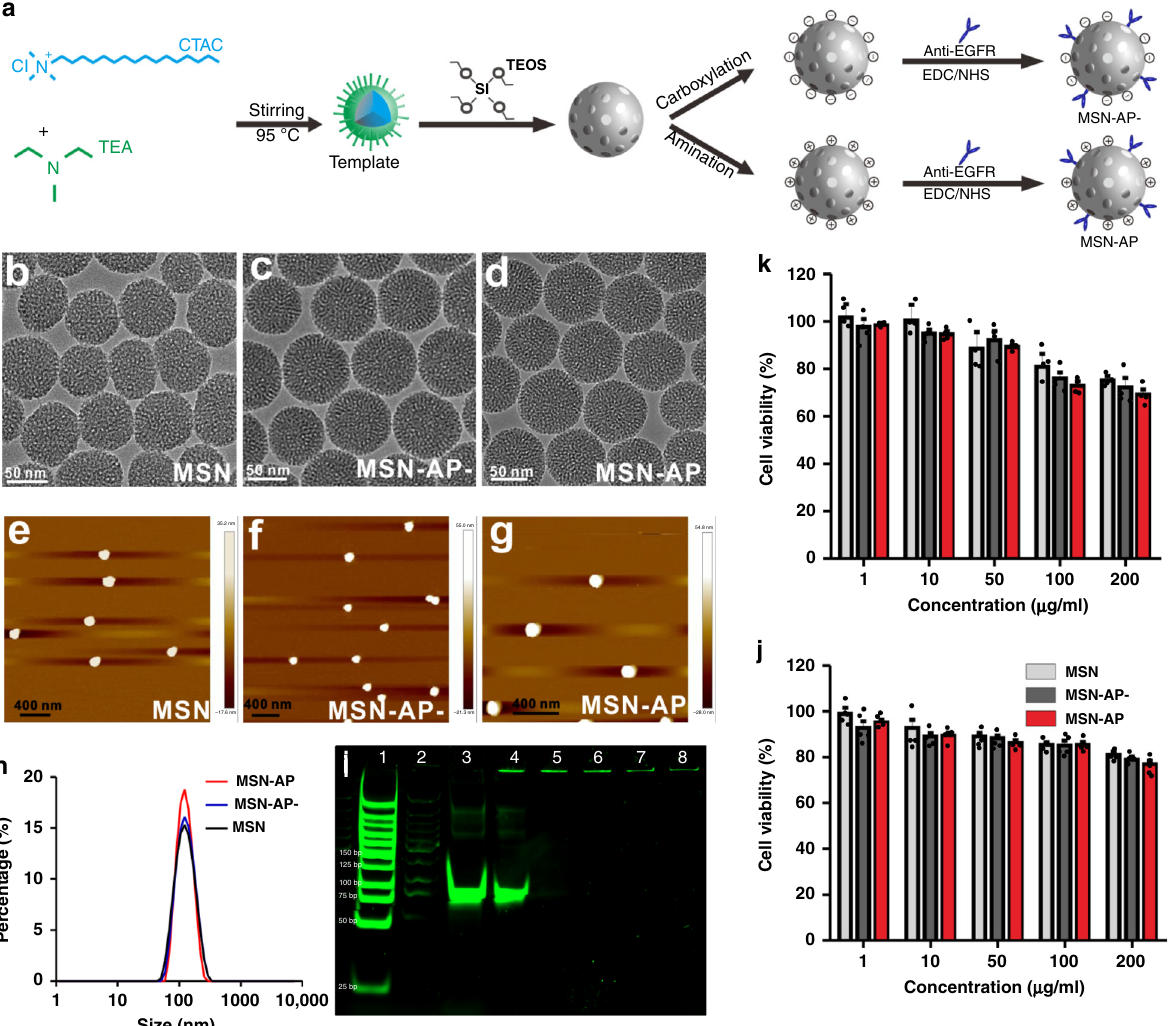
Fig. 2 MSN functionalization and characterisation. a Schematic showing the synthesis and surface modi fi cation of MSN with EGFR-targeting aptamers following carboxylation (negative charge; MSN-AP − ) and amination (positive charge; MSN-AP). b – g TEM ( b – d ) and AFM ( e – g ) images of MSN, MSN-AP − and MSN-AP. h Size distribution. i PAGE electrophoresis showing 1, markers; 2, MSN; 3, free aptamer; 4, MSN mixed with AP; 5, MSN-AP-; 6, MSN-AP; 7, MSN-AP- after 8-h incubation in blood; 8, MSN-AP after 8-h incubation in blood. j Effects of MSN, MSN-AP − and MSN-AP on viability of endothelial cells ( j ) and human hepatocyte LO2 cells ( k ). n = 5 reduplications. Data presented as the mean ± s.e.m. Source data are provided as a Source Data fi